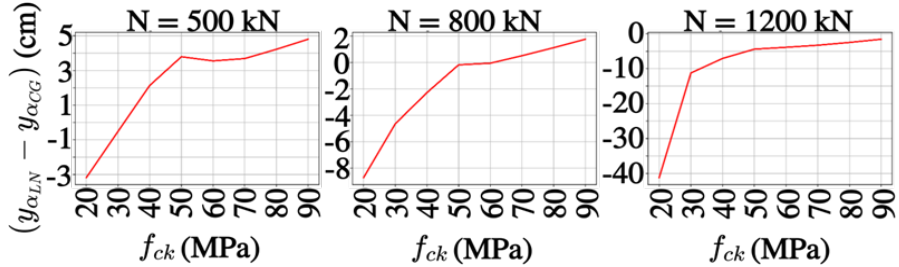
Figure 10. Relative position between neutral axis and centroid of square sections with α = 0